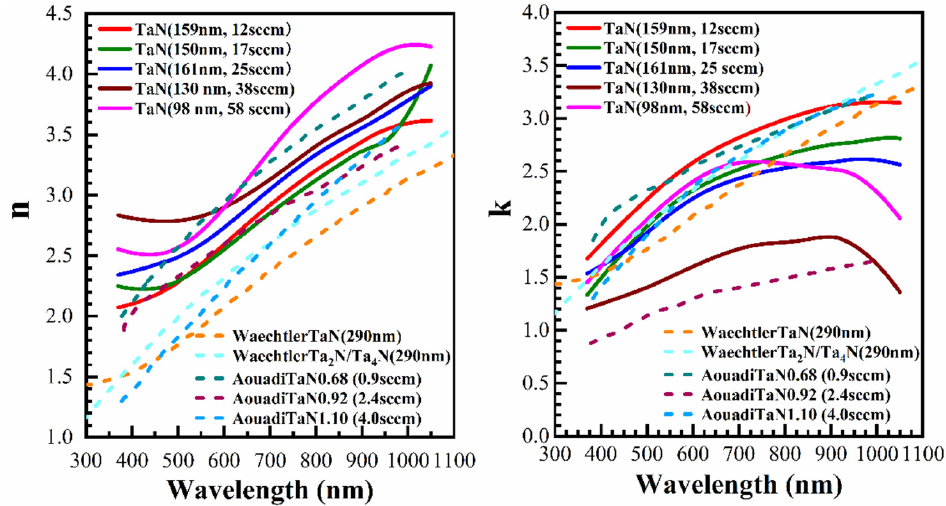
( b ) Figure 9. ( a ) The refractive index (n) and ( b ) extinction coefficient (k) of TaN(12–58 sccm) films